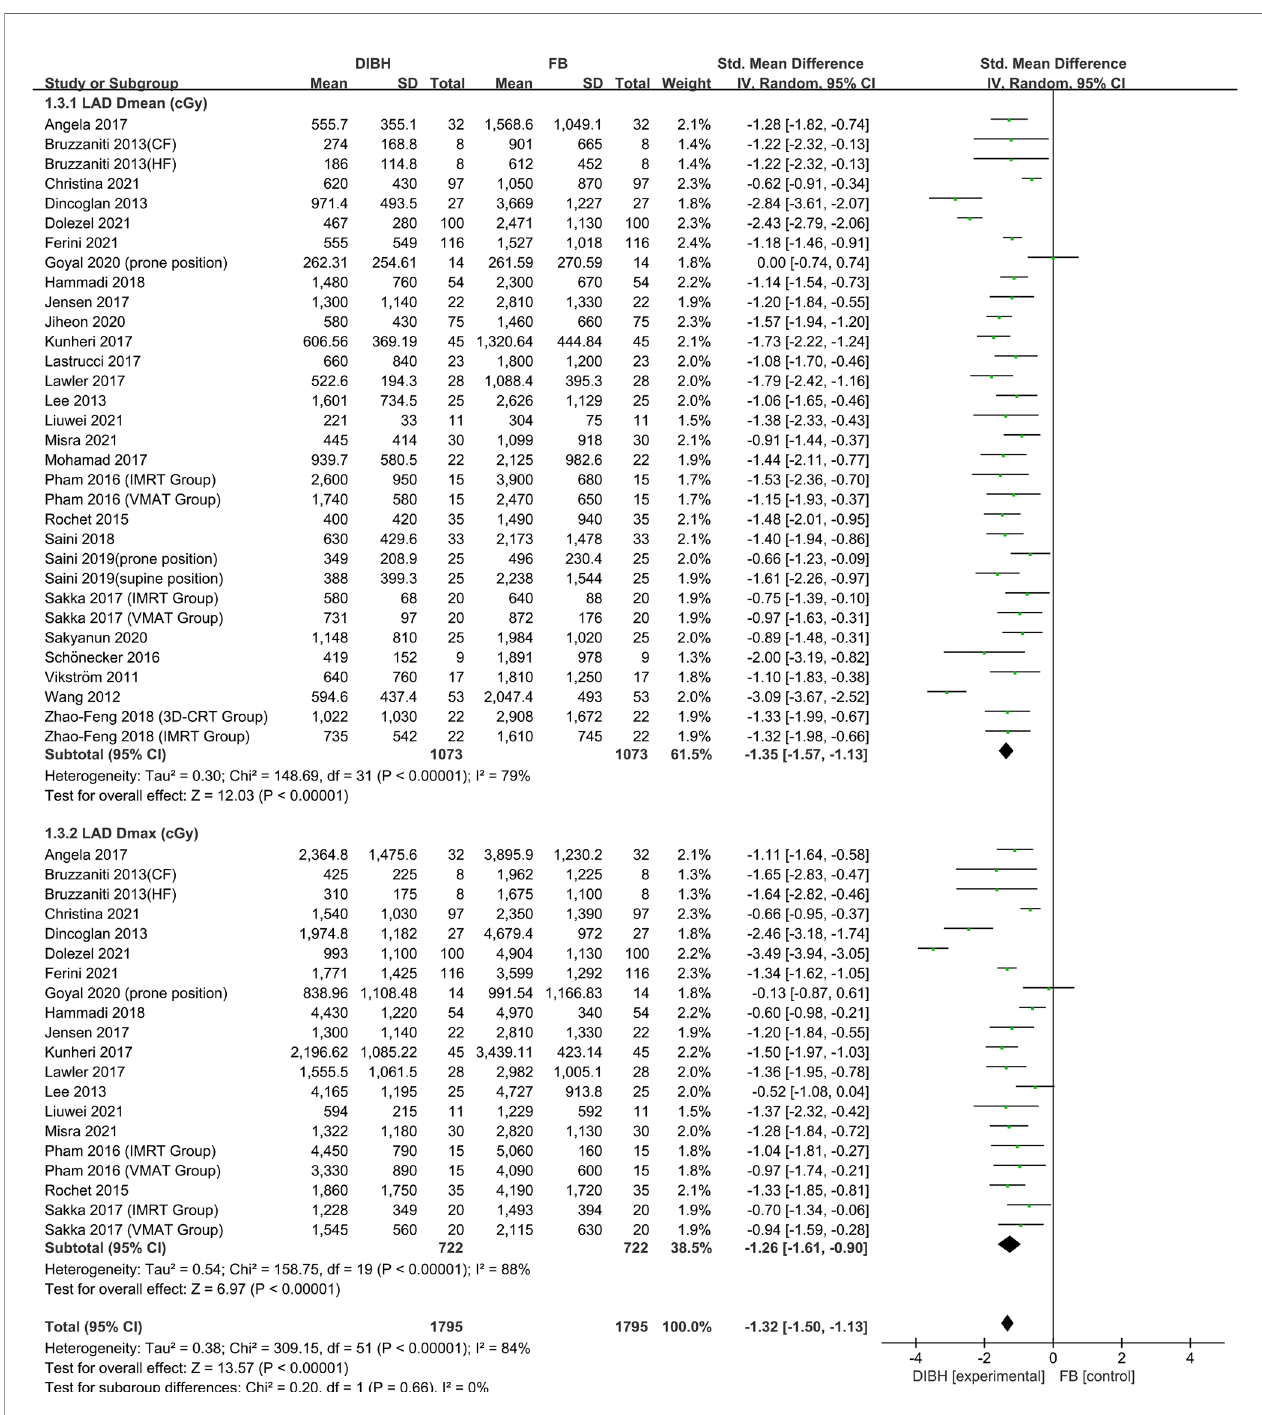
FIGURE 4 | Forest plot of LAD dose ( D mean and D max) between the DIBH group and FB